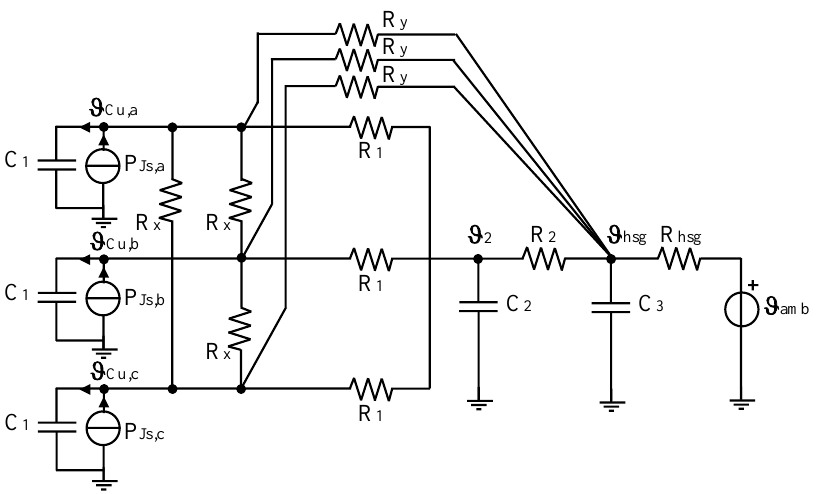
Figure 16. The concept of the proposed phase-split LPTN.